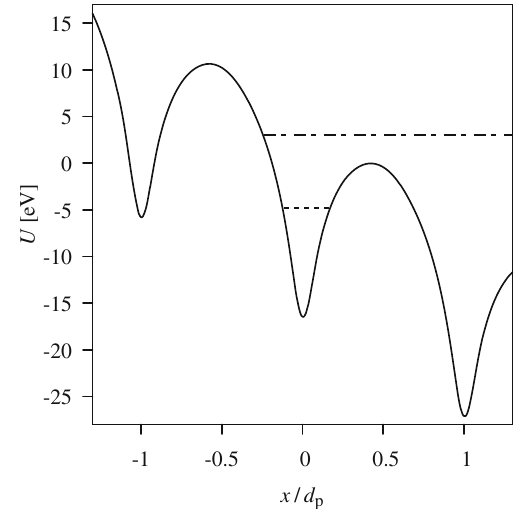
Fig. 1 An illustration of interplanar potential in a bent crystal. Dotted line corresponds to planar channeling, while dash-dotted line corre- sponds to above-barrier